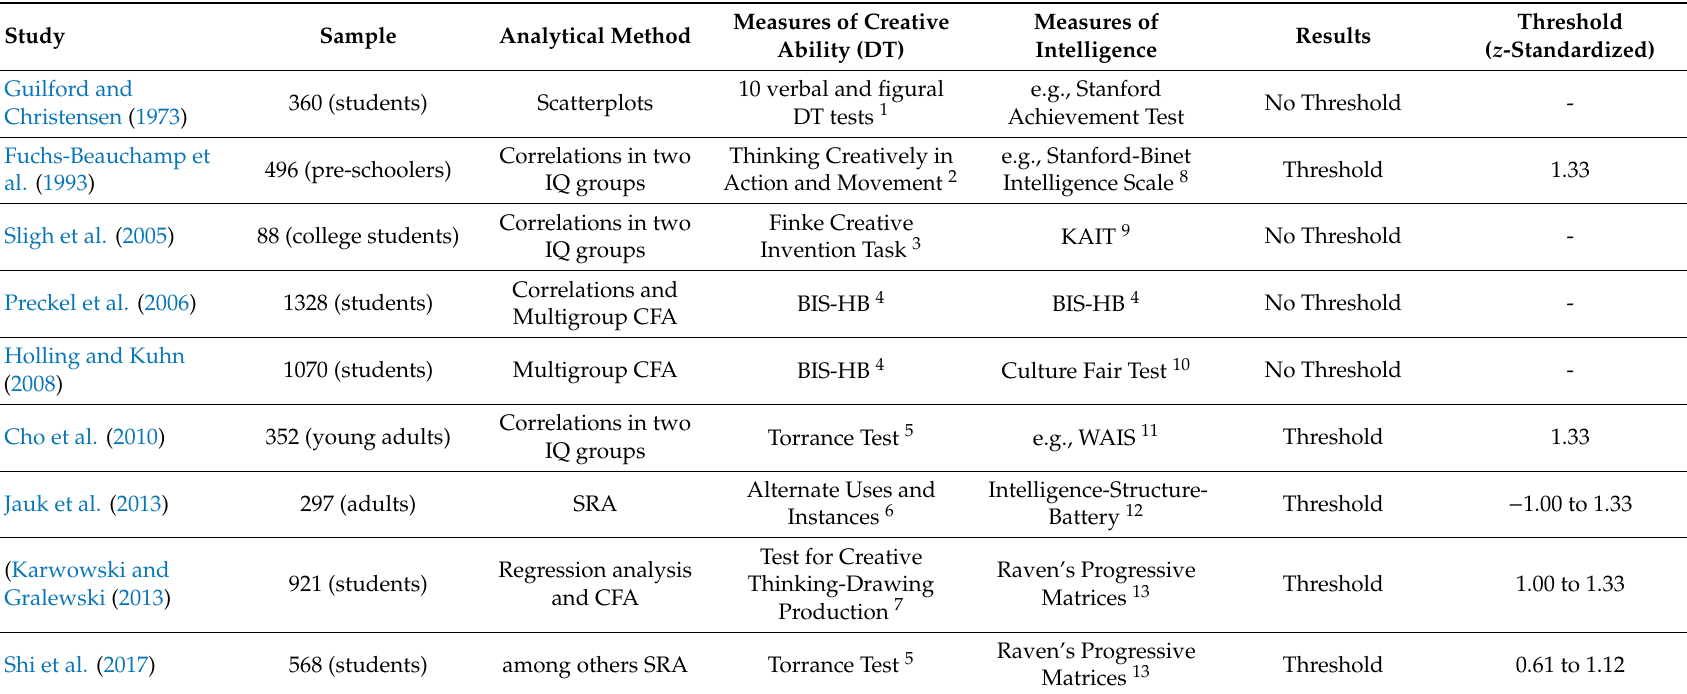
Table 1. Previous investigations in the relation of creativity and